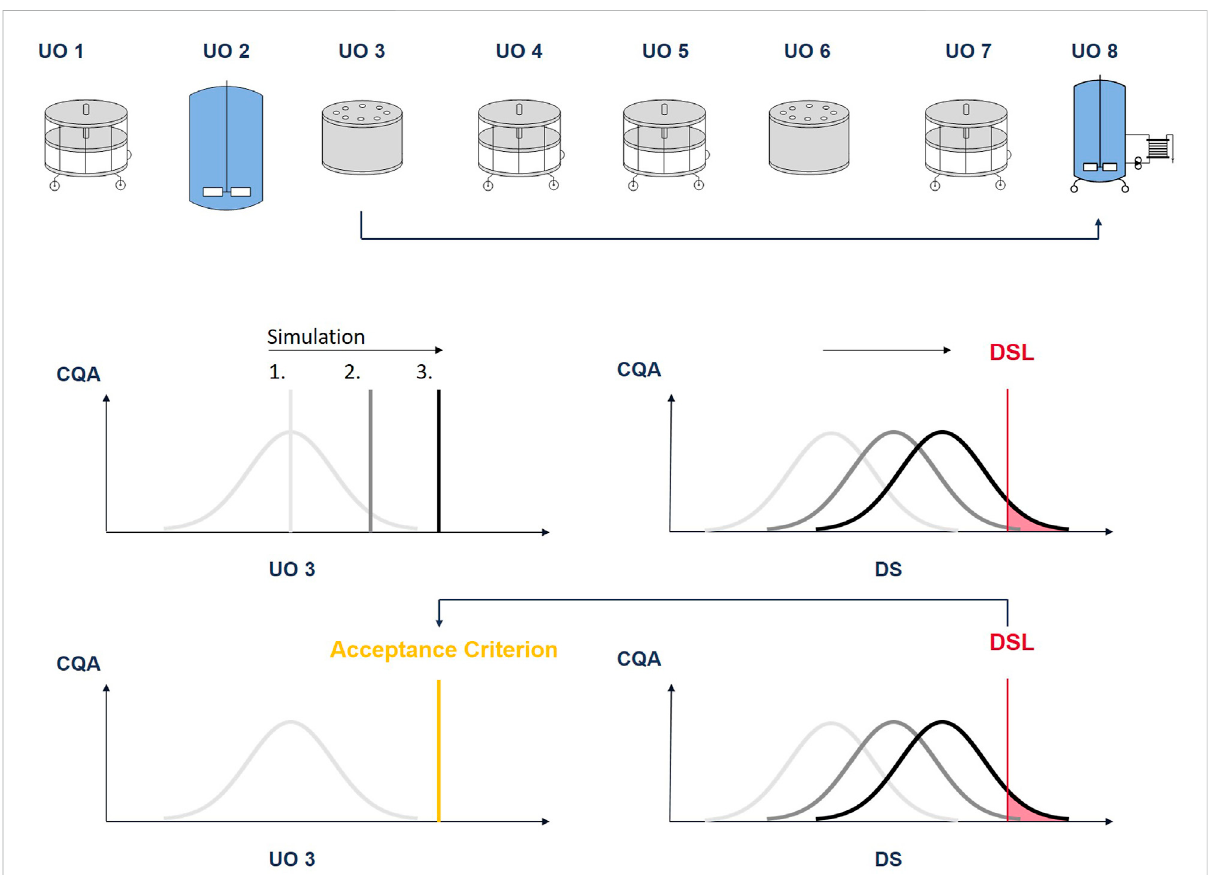
FIGURE 7 Illustration of the procedure to deriveintermediateacceptance criteria: The CQApoolvalueatunitoperation 3isincreased in discrete steps. At eachstepaMonteCarlosimulationisperformed. Witheach step,theCQAdistributionatDSmovestowards thedrug substancelimit(DSL).Thepool value, where a prede fi ned fraction of the CQA distribution lies outside the DSL (out-of-speci fi cation probability), will de fi ne the